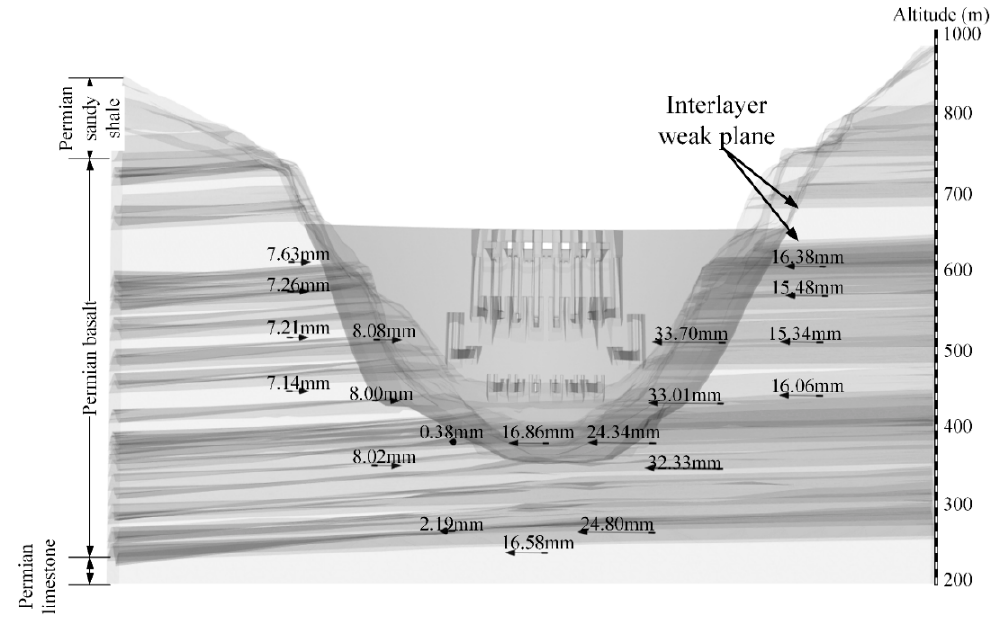
Figure 9. Figure 9. Horizontal deformation pattern of the rock base (upstream view, November 2012– November 2019).